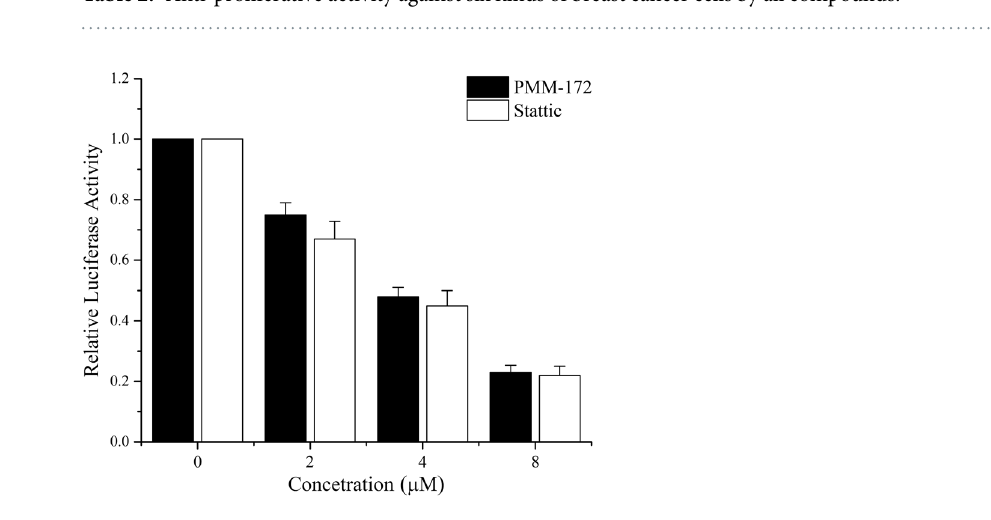
Figure 3. MDA-MB-231 cells were transfected with STAT3-TATA-Luc reporter and Renilla luciferase reporter plasmids. After 24 h, cells were treated with indicated concentrations of PMM-172 or Stattic for 24 h and then luciferase intensity was measured. Results are fold change ± SD of three independent experiments, * P < 0.05, ** P <